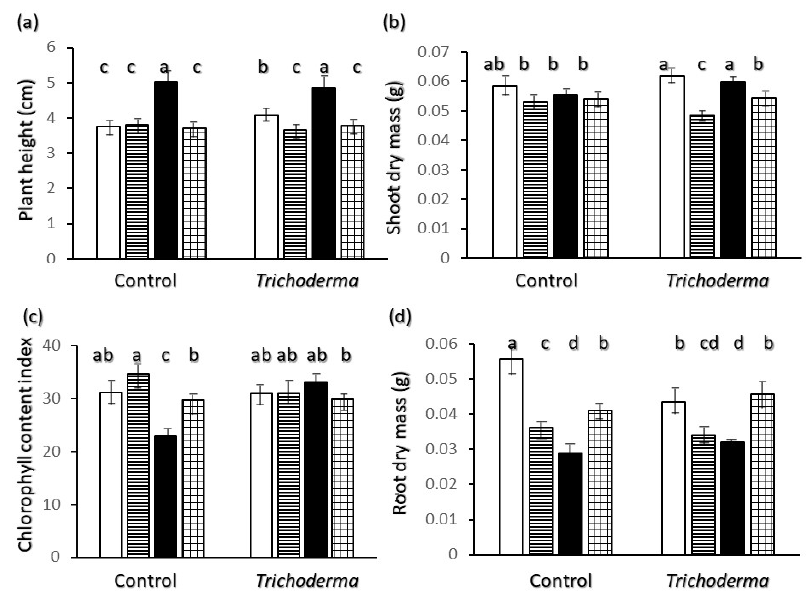
Figure 1. Interaction of wheat variety x Trichoderma harzianum T-22 inoculation on overall growth data: ( a ) height to the uppermost node; ( b ) shoot dry mass; ( c ) Chlorophyll Content Index; ( d ) root dry mass. Color code of bars: white = Ciclope; horizontal stripes = Creso; black = Saragolle; grid = Simeto. Vertical segments on each bar indicate standard deviation n = 6. Different letters on each bar designate significantly different values for p < 0.05 at the Tukey’s post hoc mean separation test.